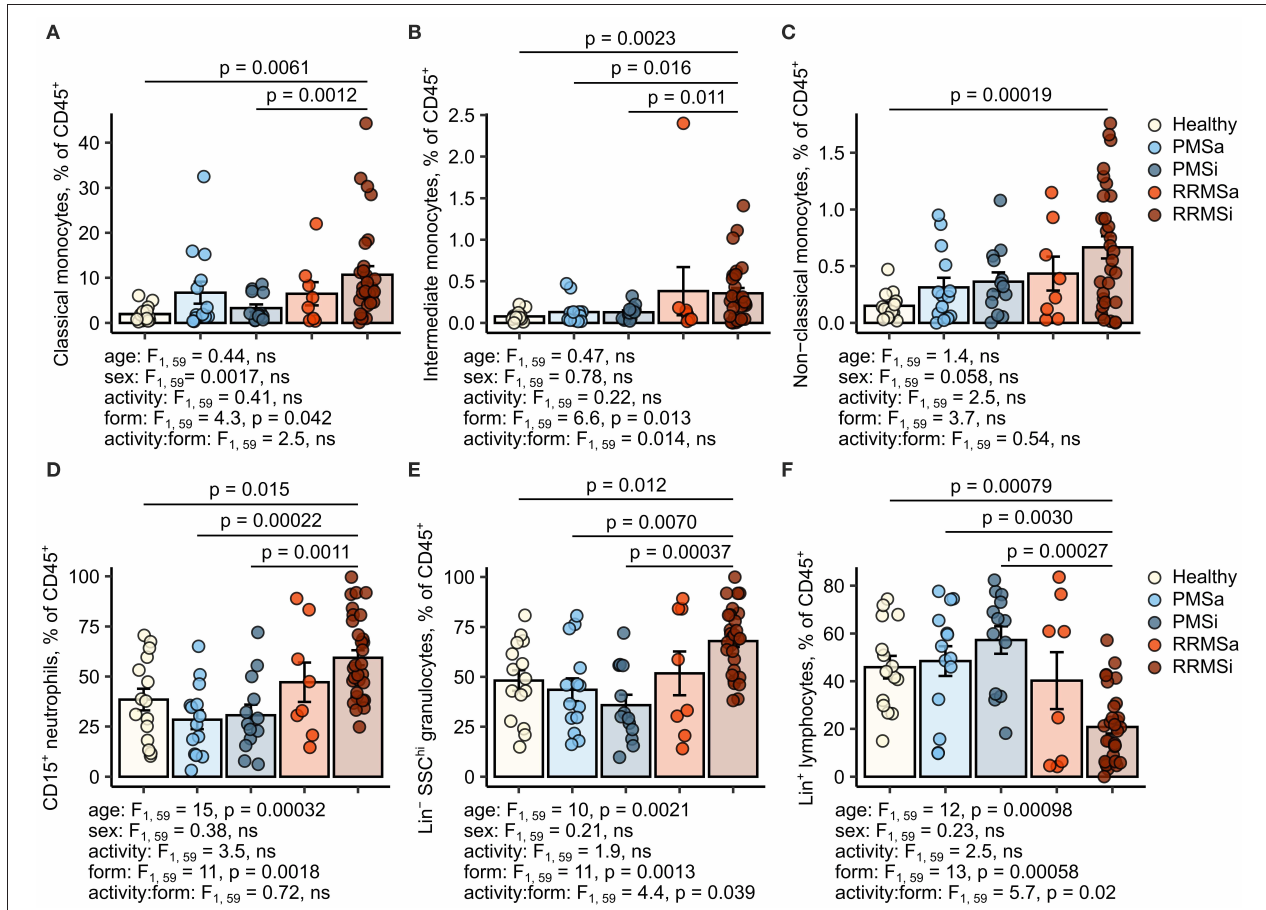
FIGURE 4 | Increased percentages of neutrophils and classical and nonclassical monocytes in inactive relapsing-remitting multiple sclerosis (RRMSi) individuals. Lineage + lymphocytes, Lineage − SSC hi granulocytes, CD15 + neutrophils, and monocyte subpopulations were identified in whole-blood samples from healthy controls ( n = 15) and MS patients stratified by disease course type [active progressive MS (PMSa): n = 14, inactive progressive MS (PMSi): n = 13, active relapsing-remitting MS (RRMSa): n = 8, and RRMSi: n = 30] as presented in Supplementary Figure S1 . Levels of the studied populations are expressed as percentages of CD45 + blood leukocytes. Each point denotes a single observation, bars depict group-wise means, and error bars represent SEM. Statistical significance was determined by one (healthy/MS disease status) and two-way (disease progression form, activity and form: activity interaction, MS collective) analysis of covariance (ANCOVA) with age and sex as confounders. Results of the two-way ANCOVA are presented under the plots. post hoc testing was performed with Benjamini–Hochberg-corrected two-tailed T tests. Significant results of post hoc test are presented within the plots. (A) Classical monocytes. ANCOVA for the disease status: F 1,76 = 5.6, p = 0.020; age: F 1,76 = 0.2, ns; sex: F 1,76 = 0.54, ns. (B) Intermediate monocytes. ANCOVA for the disease status: F 1,76 = 4.3, p = 0.042; age: